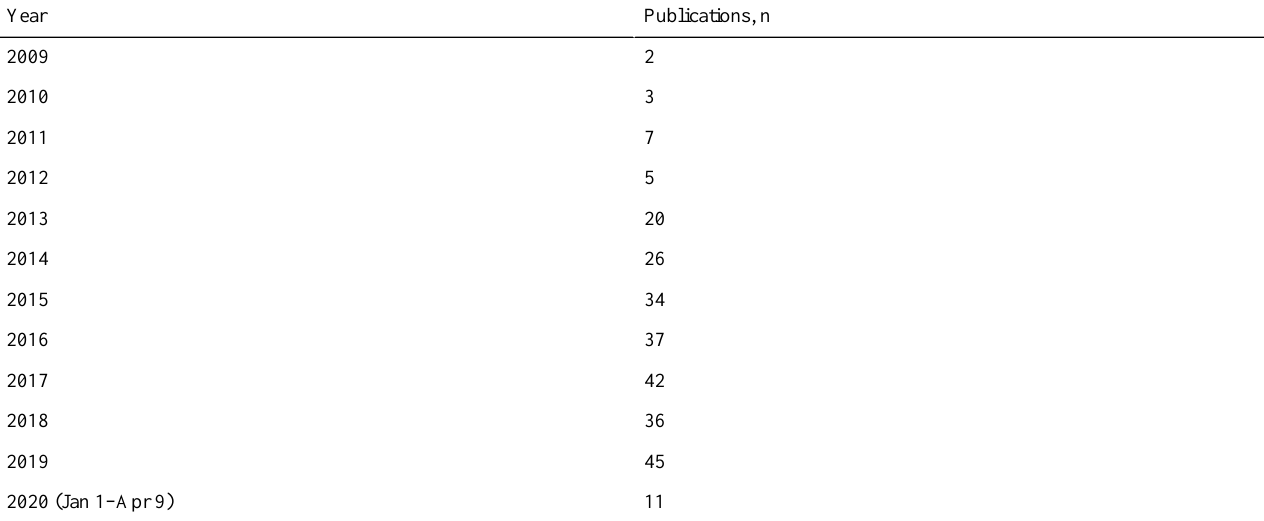
Table 2. Distribution of publications by year of publication.